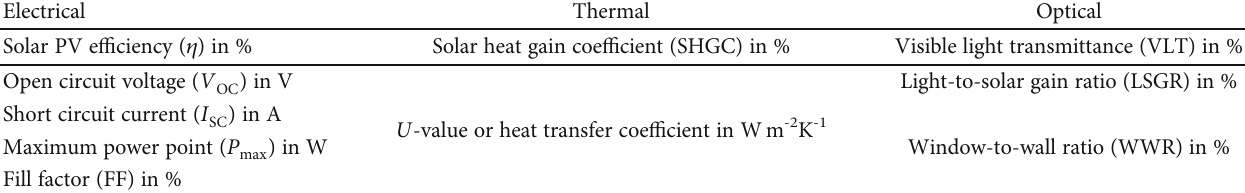
Table 3: Summary of the basic parameters of the semitransparent